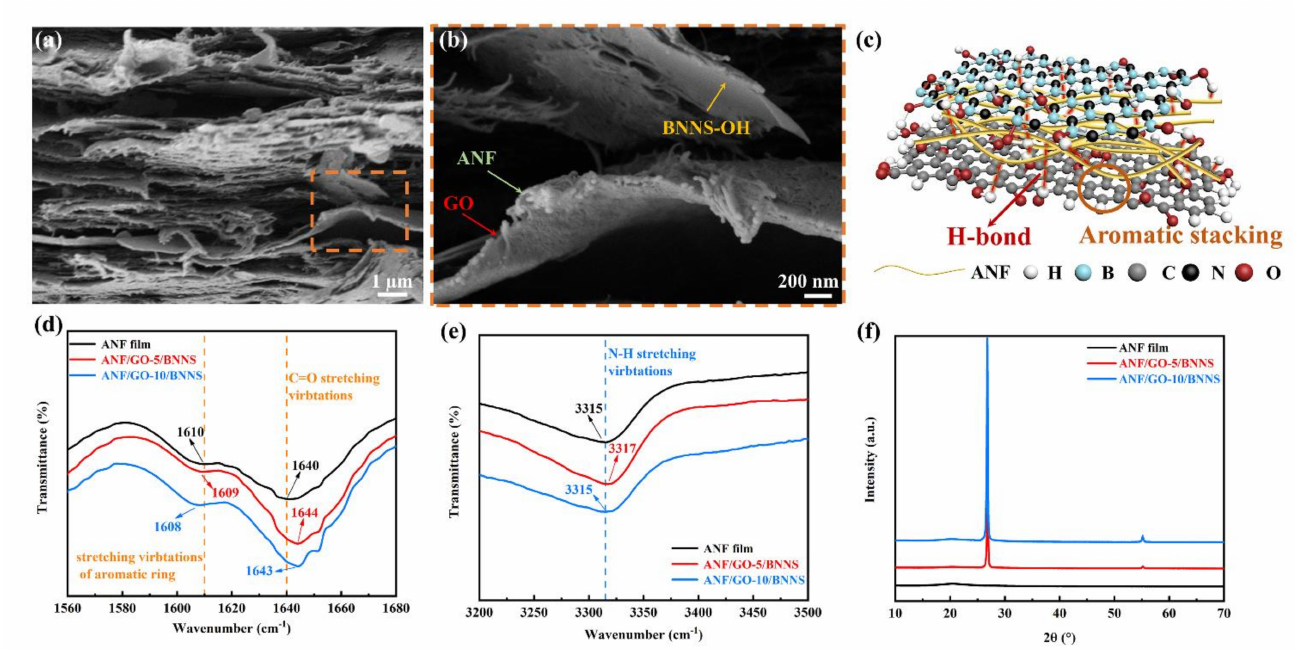
Figure 3. ( a ) Cross-section morphologies of ANF/GO/BNNS film at low magnification. ( b ) Partial enlarged view of cross- section morphologies of ANF/GO/BNNS film. ( c ) Diagram of hydrogen bonding and π – π stacking inner ANF/GO/BNNS composite film. ( d , e ) FT-IR spectra of ANF film, ANF/GO-5/BNNS, and ANF/GO-10/BNNS composite films. ( f ) XRD patterns of ANF film, ANF/GO-5/BNNS, and ANF/GO-10/BNNS composite